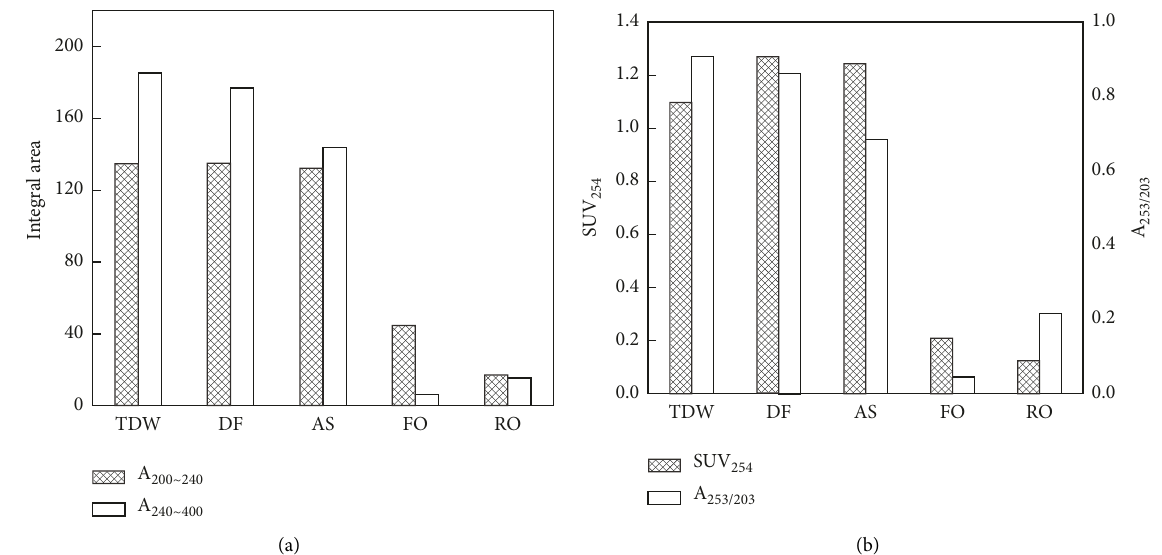
Figure 5: (a) Variation of the integrated area of absorbance at A variation of SUV 254 and A 253/203